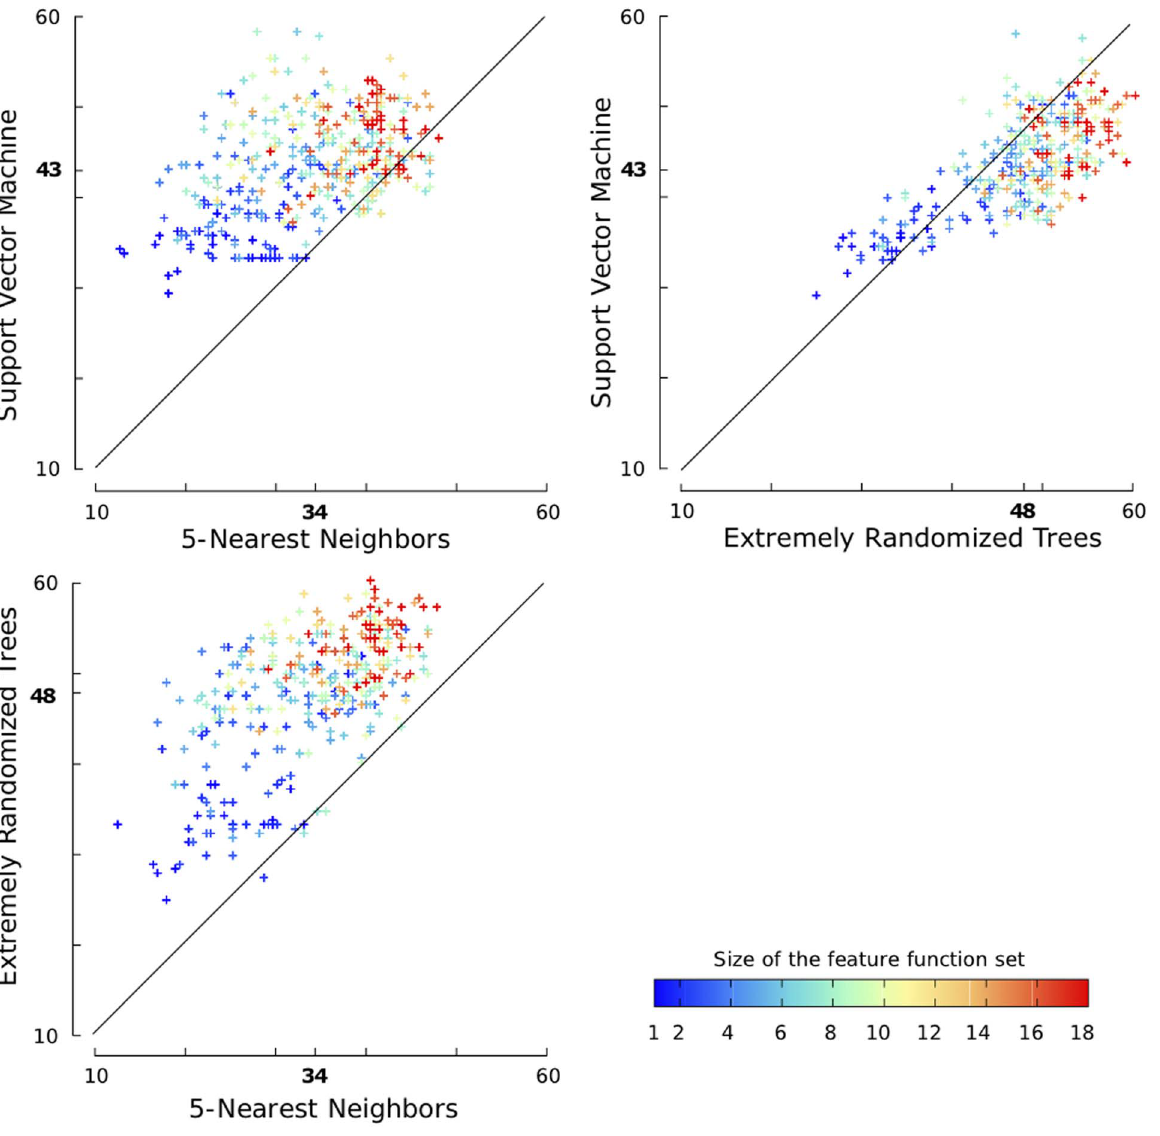
Figure 4. Q p scores for three binary classification algorithms and randomly sampled feature function sets. The experiments are performed on the SPX z dataset. In bold, the means of the classifiers. The diagonal lines indicate situations where both classifiers have the same score. The experiments are color-encoded w.r.t. the size of their feature function set.